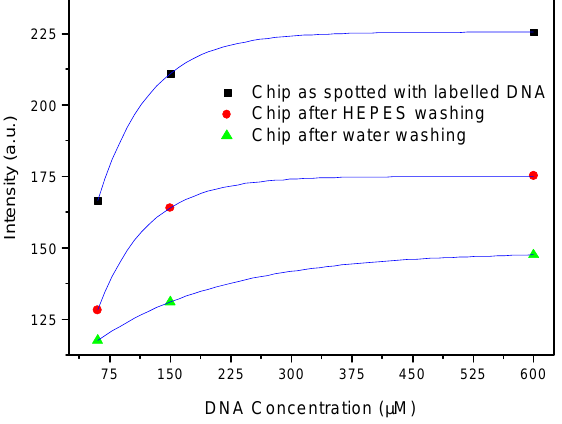
Figure 4. Fluorescence intensities of the chip surface after the binding of the labelled ss DNA and the two overnight dialysis as a function of the c DNA